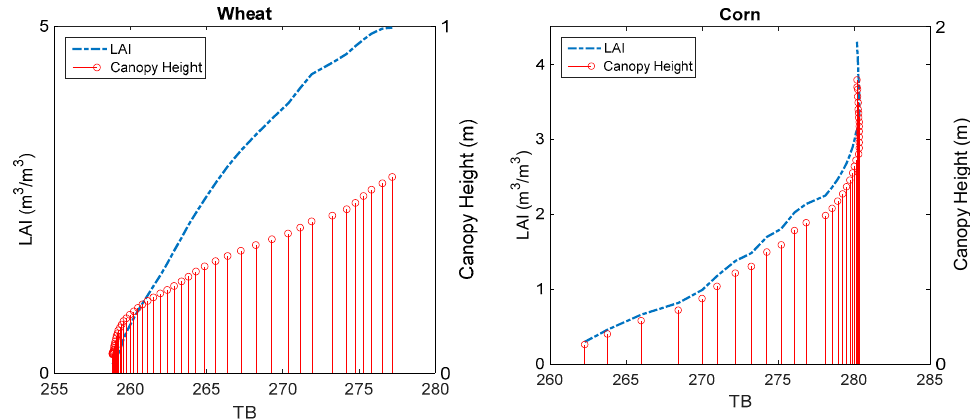
Figure 10. Comparing LAI trend with brightness temperature and canopy height ( left: wheat, right: corn).